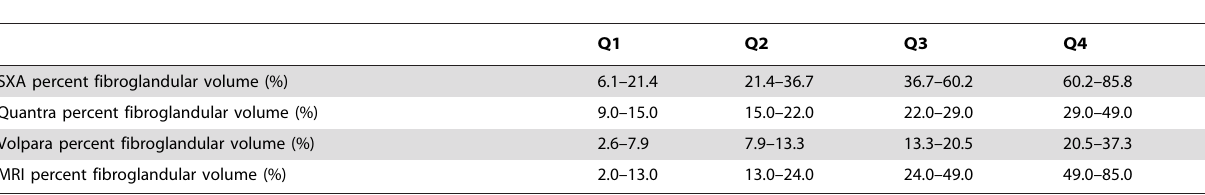
Table 3. Percent fibroglandular density quartile ranges by method (n= 99).